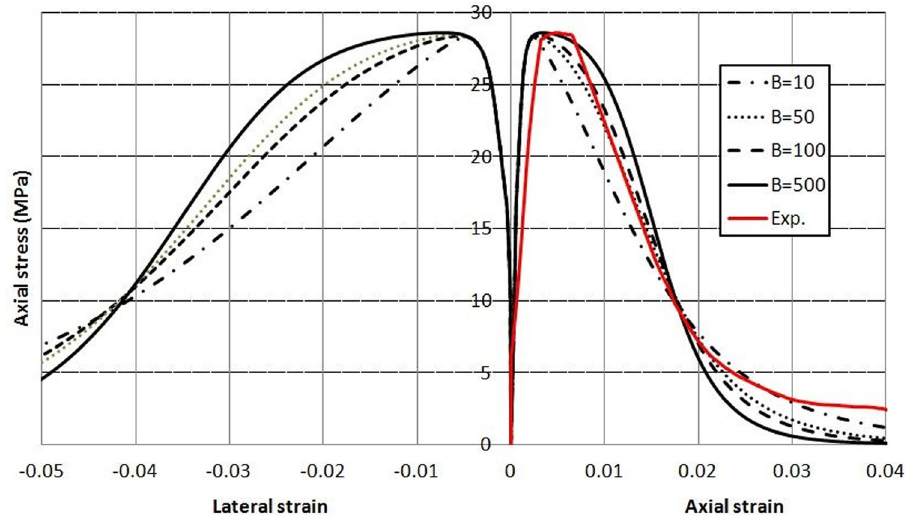
Fig. 3 Comparison of uniaxial compression behavior of CSCM model and experimental data taken from Mousavi et al.